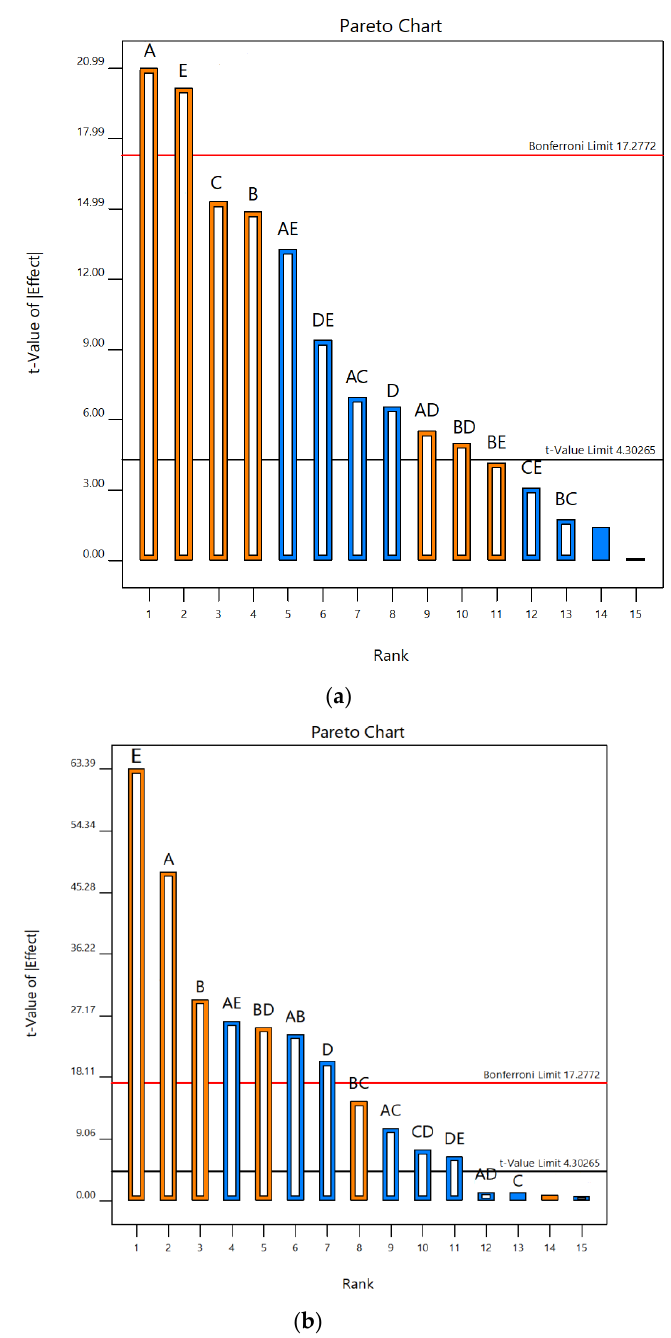
Figure 1. Pareto charts showing influence of five UAE parameters (A temperature; B extraction time; C ethanol concentration; D ultrasonic power; E liquid – solid ratio) on contents of ( a ) TP and ( b ) TMA in vacuum dried sour cherries extracts.